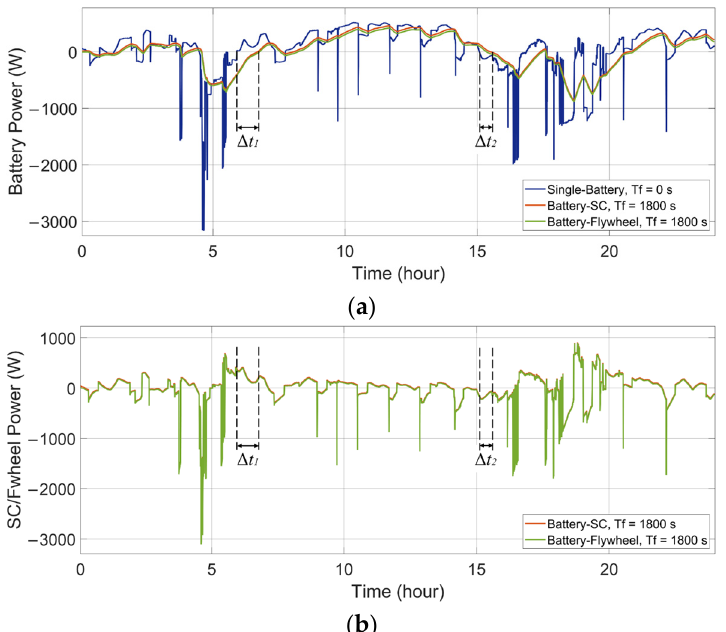
Figure 5. Power flows of the ESDs in the single-battery ESS and the HESSs applied to a wind-powered household-prosumer system. ( a ) Battery power. ( b ) SC/flywheel power.